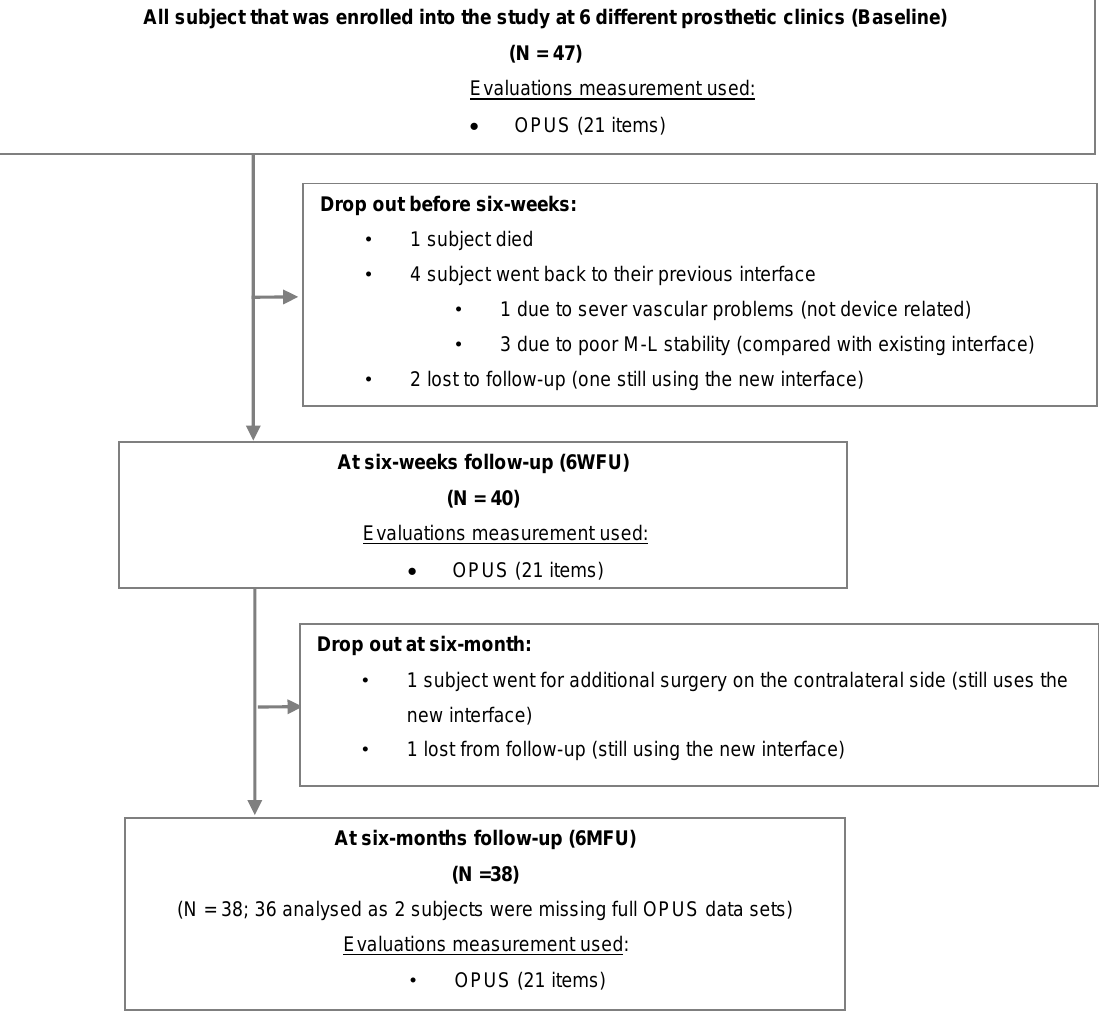
Figure 3: Flow chart of the